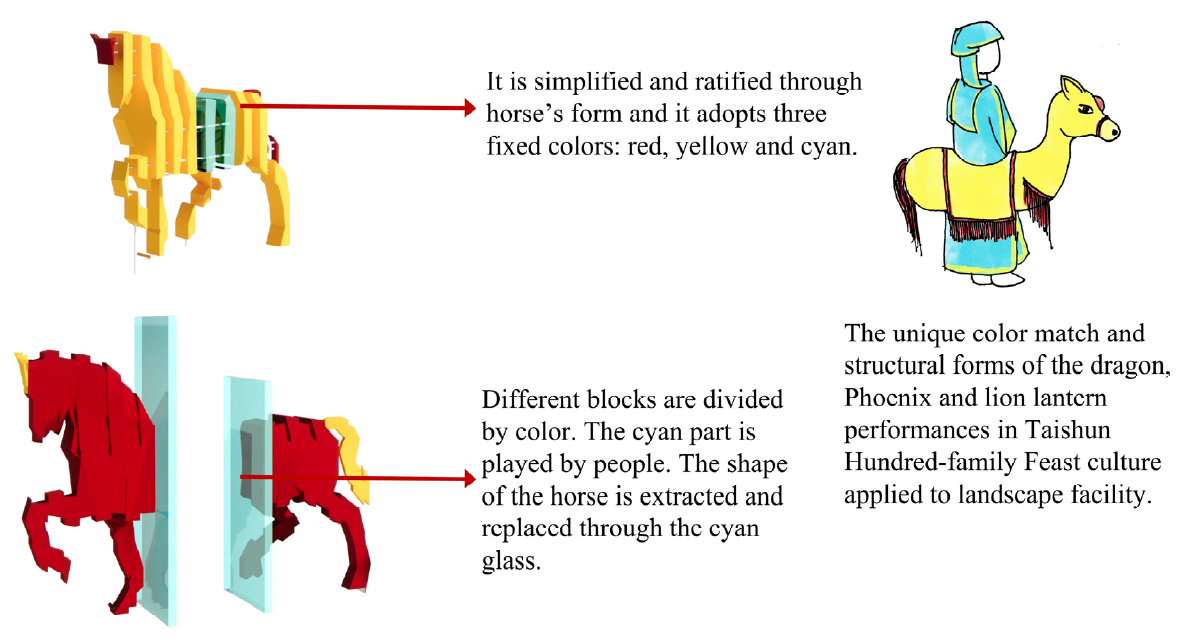
Figure 20. Dragon phoenix and lion lamp.